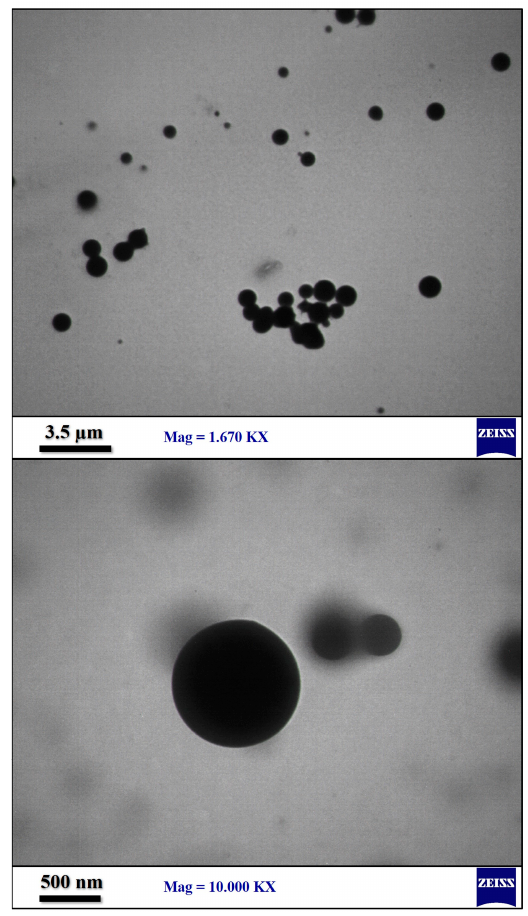
Figure 7. TEM micrographs of surface modified NPs by PDA.